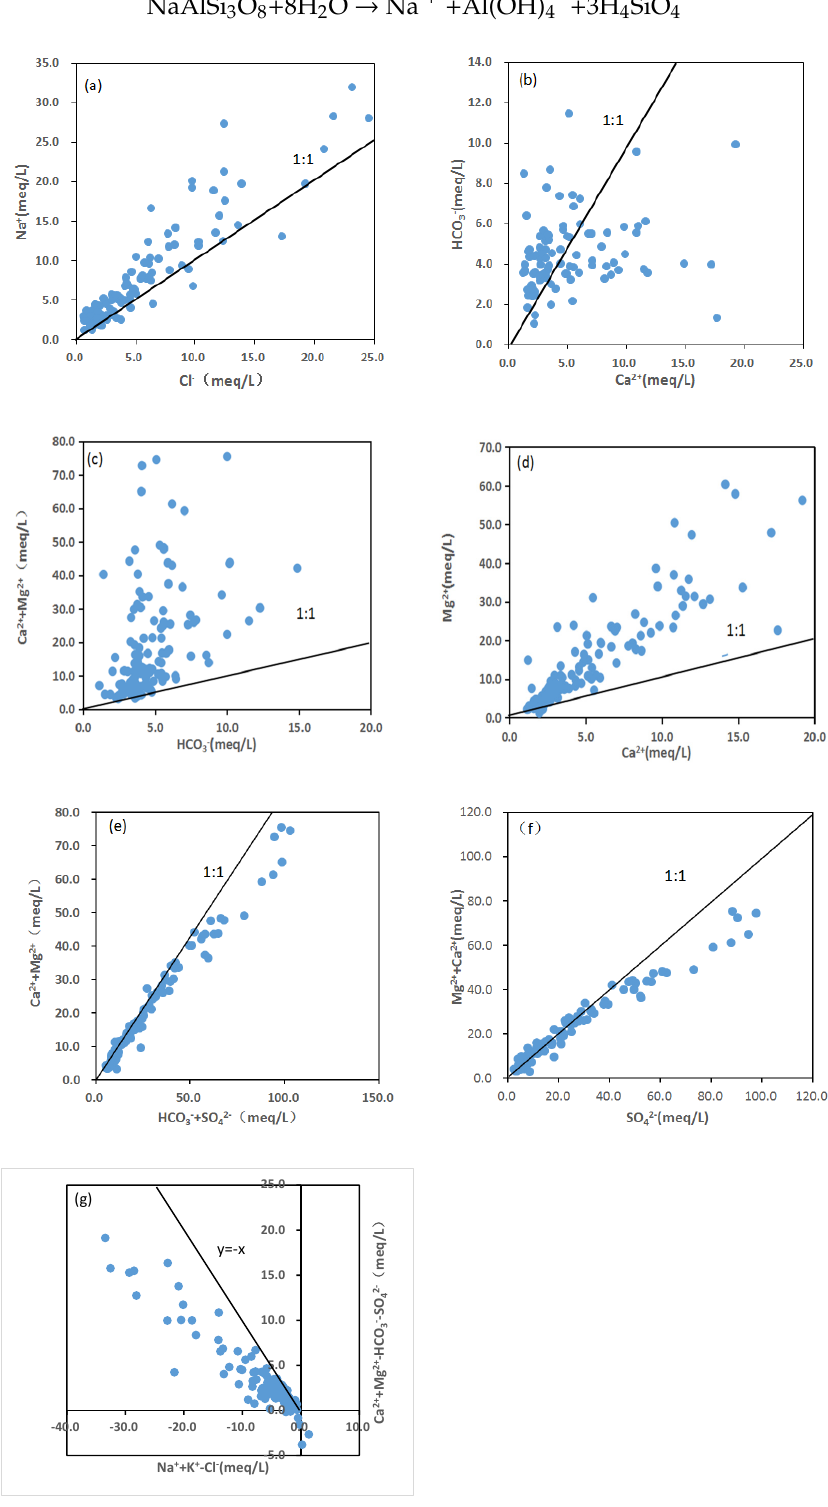
Figure 6. Ratio graphs of ions in groundwater samples collected from the Jinta Basin, China.( a ) Na + versus Cl − , ( b ) HCO 3 − versus Na + , ( c ) Ca 2+ + Mg 2+ versus HCO 3 − , ( d )Mg 2+ versus Ca 2+ , ( e ) Ca 2+ + Mg 2+ versus HCO 3 − + SO 42 − , ( f ) Ca 2+ + Mg 2+ versus SO 42 − ,( g ) Ca 2+ + Mg 2+ - HCO 3 − -SO 42 − versus Na + + K + - Cl −